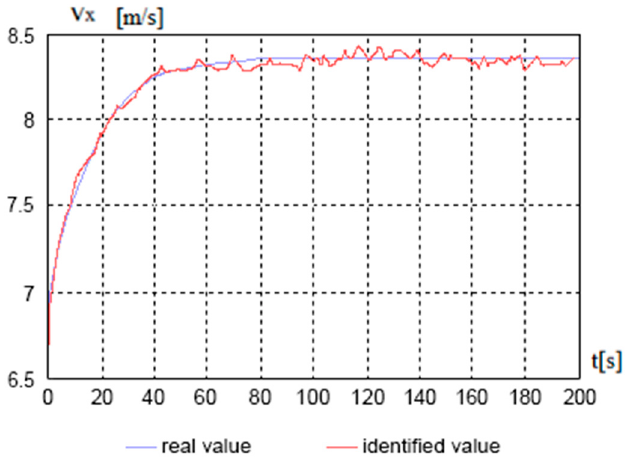
Figure 1. Estimation of the speed of rectilinear movement. In Equation (1) m 11 = m c + ∆ m 11 , m 22 = m c + ∆ m 22 —the mass of ship with entrained water; J zp = J zc + ∆ J zp —vessel’s moment of inertia with attached water inertia moment; (cid:113) (cid:113) (cid:113) + v 2 v = v 2 v 2 + ( ω Z L r ) 2 , v 2 = v 2 + ( ω Z L r ) 2 —water flow rate modules, , v 1 = x y respectively, in the area of the ship’s center of mass, bow and rudder; ρ v 2 ρ v 2 2 β = − arcsin v y 1 2 —leeway angle; ρ —water density; q = ρ v , q 1 = , q 2 = —dynamical v 2 2 2 pressure; ω Z = ω Z L , ω r = ω Z L r —relative angular v 1 v 2